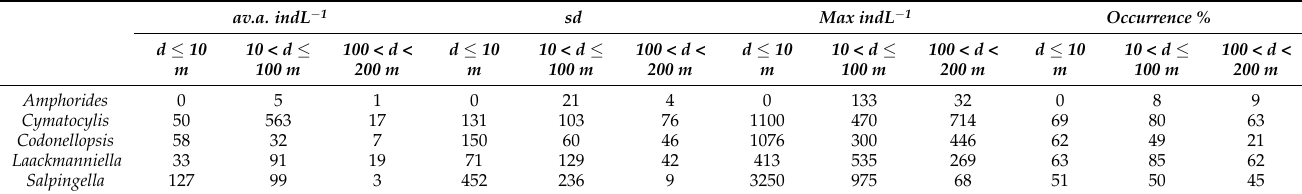
( sd ), maximum abundance detected (max indL − 1 ), and percentage of presence in the analyzed